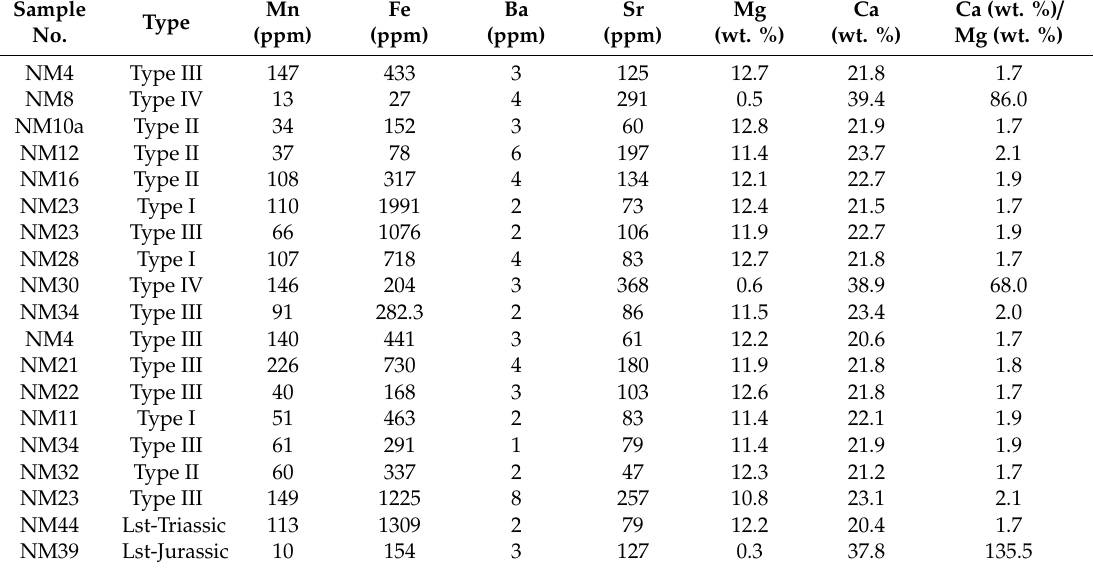
Table 1. Elemental analysis of diagenetic phases from Triassic and Jurassic samples ( n =